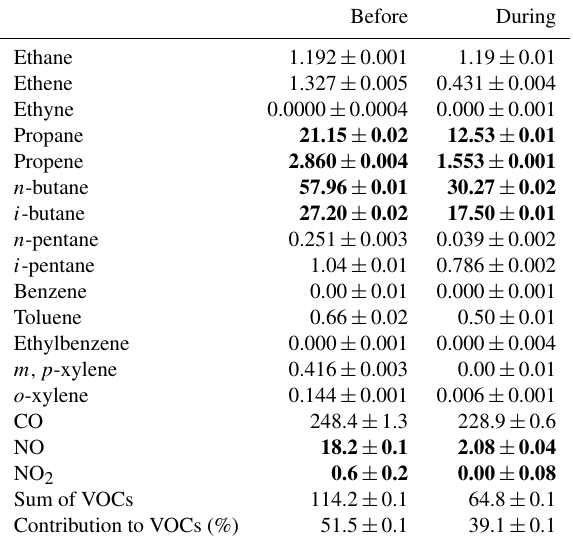
Table 7. VOCs and trace gases emitted from LPG-fueled vehicles before and during the intervention program (unit: µgm − 3 unless otherwise specified). The standard errors are estimated with the bootstrap method in the PMF model. The bold fonts demonstrate significant reductions of LPG related VOCs and NO x . Before During